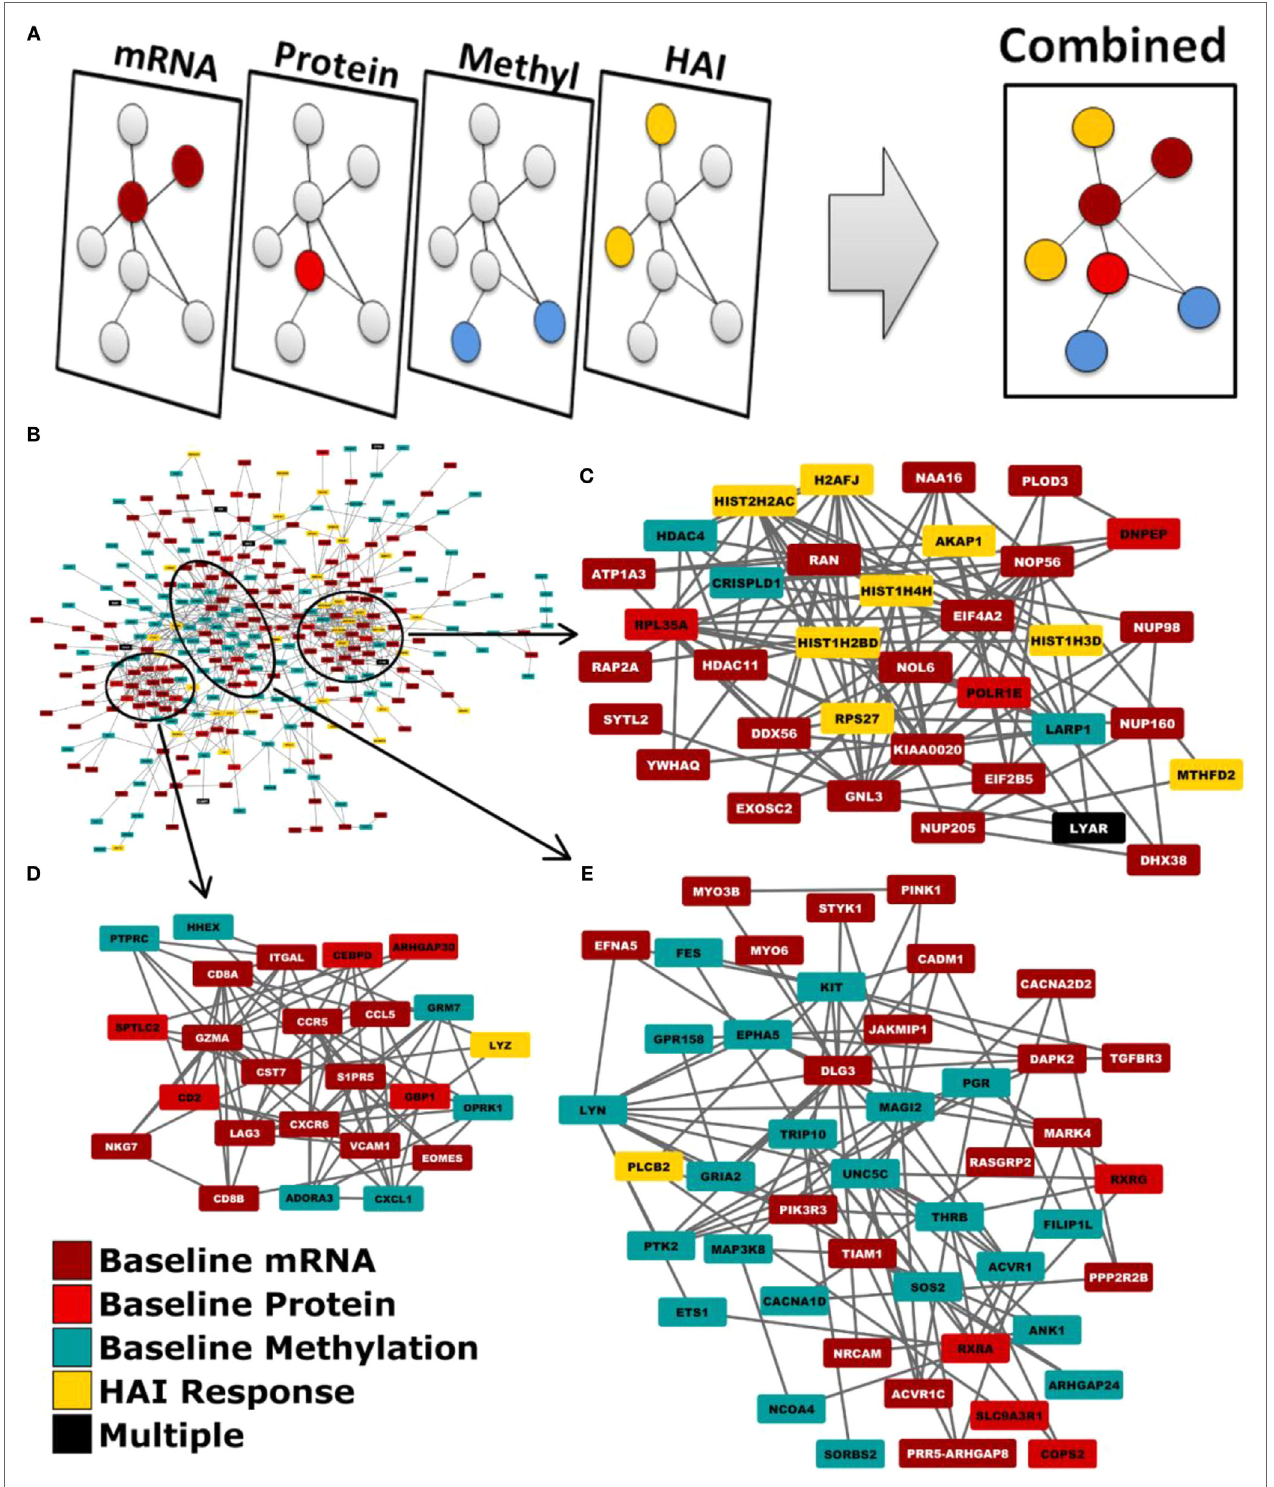
FigUre 2 | network biology integration of immunosenescence-related datasets . (a) Each of our omics data types were mapped to genes and projected onto a common network. (B) This network diagram revealed functional links between the genes indicated by each data type. Three groups are evident within the network by the extent of their interconnectivity. (c) One group is highly concordant with M7.16 ( q = 1.26xl0 − 7 ). (D) Another with the M3.6 cytotoxic T cell module ( q = 6.31xl0 − 5 ). (e) The third is overlaps the canonical KEGG chemokine signaling ( q = 3.98xl0 − 5 ).